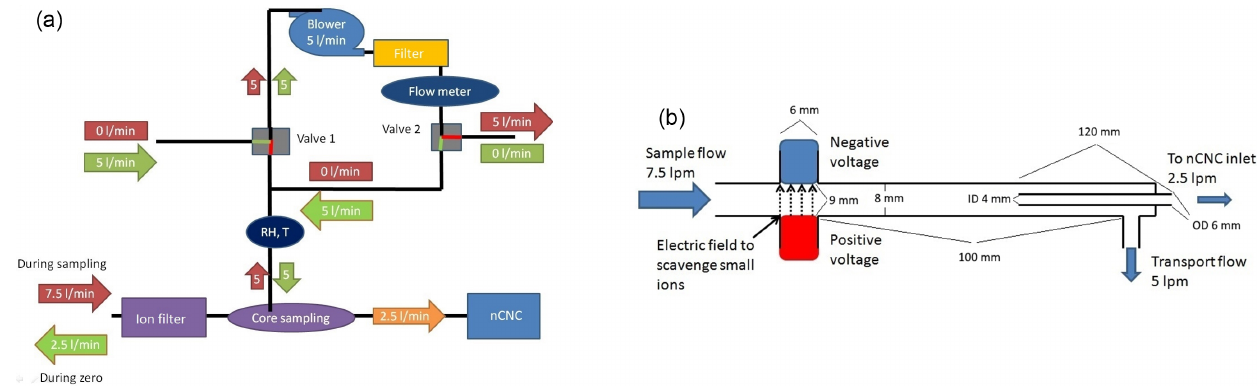
Figure 3. Schematic of the inlet system. The upper panel (a) presents the flow schematics, the lower panel (b) presents the schematic of the core sampling and ion filter arrangement. The given dimensions are not in scale in the figure.